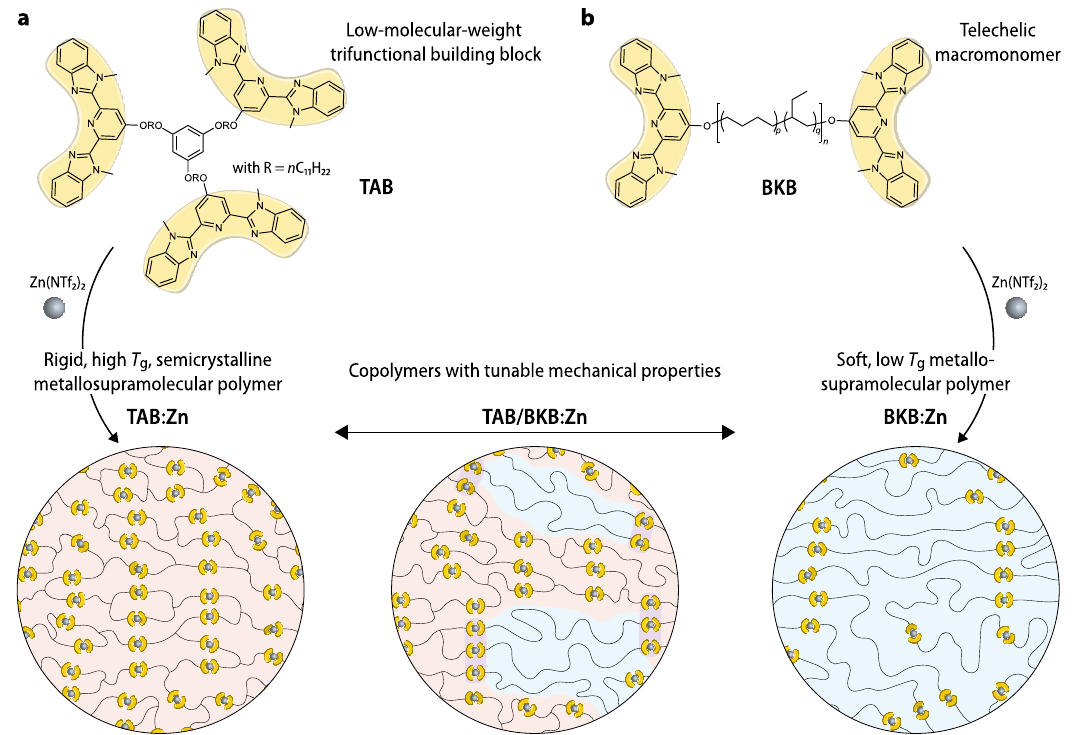
Fig. 1 Structure of metallosupramolecular copolymers. The individual metallosupramolecular polymers were assembled by combining Zn(NTf 2 ) 2 with ( a ) a trifunctional building block based on a 1,3,5-tris(alkyl)benzene core and three 2,6-bis(1 ′ -methylbenzimidazolyl) pyridine (Mebip) ligands (TAB) or ( b ) a telechelic poly(ethylene- co -butylene) featuring two Mebip ligands (BKB). The co-assembly of different weight fractions of the two building blocks in the presence of stoichiometric amounts of zinc(II)bis(tri fl uoromethanesulfonyl)imide (Zn(NTf 2 ) 2 ) afforded metallosupramolecular copolymers TAB/ BKB:Zn that feature a phase involving ligands of both monomers (purple) as well as domains of the individual TAB:Zn (orange) and BKB:Zn (blue)